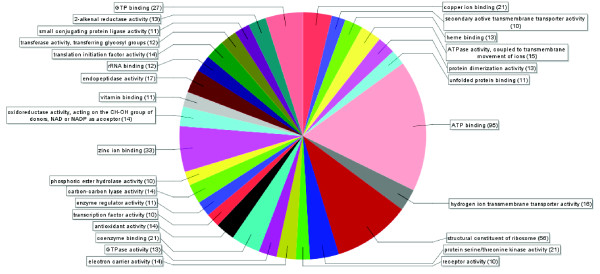
Description of the molecular functions of mapped Lolium unigenes. Mapped unigenes were grouped into functional classes based on Gene Ontology (GO) using the Blast2GO search tool [56] and represented a broad spectrum of molecular functions active in different cellular components.